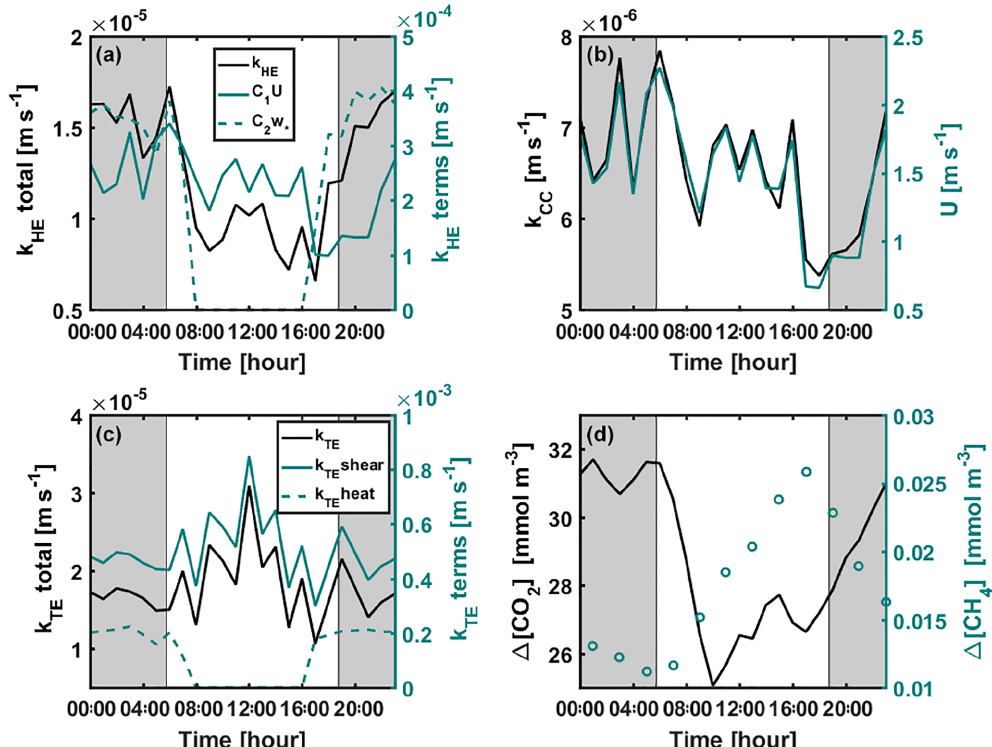
Figure A1. Diurnal variation of (a) k HE and its shear and convective terms (Eq. 9), (b) k CC and wind speed, (c) k TE and its shear ( k TE shear = c between air and surface water during the stratified period 11–21 September 2014. Shear and convective terms in subplots (a) and (c) are not corrected with the Schmidt number. Grey areas represent